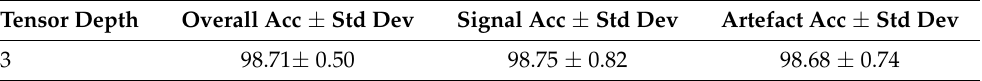
Table 4. CNN model performance for raw data set. Results have been estimated using repeated k-fold validation (5 rounds with 5 folds each).